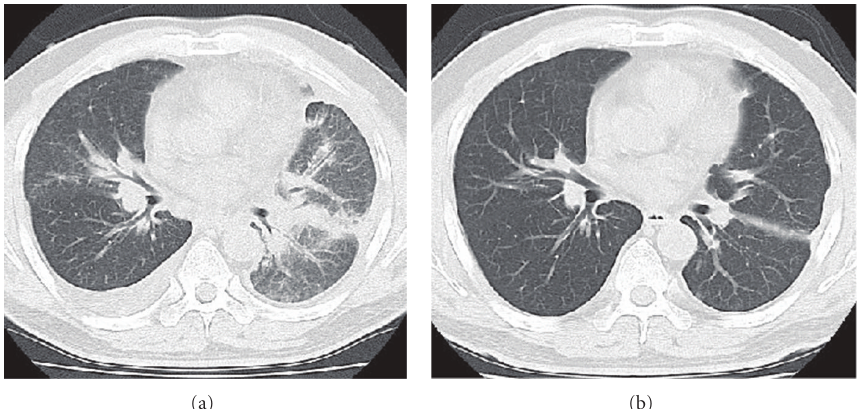
Figure 1: Chest CT of case 1 before chemotherapy demonstrating di ff use pleural dissemination of the tumor and irregular thickening of the bronchovascular bundle, indicating carcinomatous lymphangitis, and right pleural e ff usion (a). CT after two cycles of chemotherapy showing significant response (b).